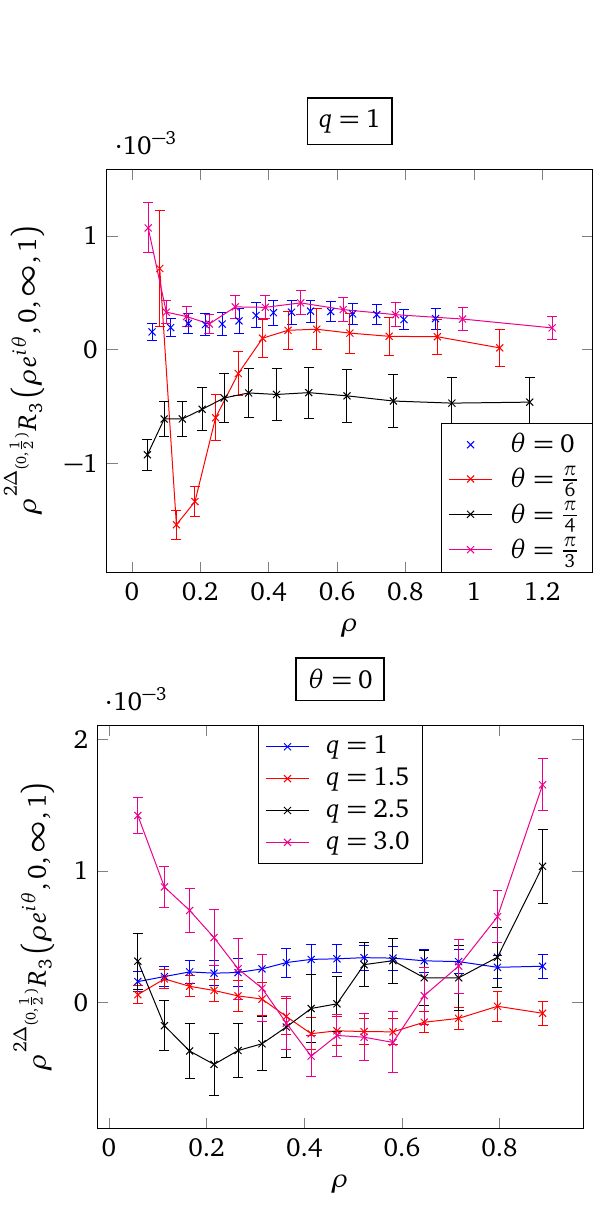
Figure 2: Differences between Monte-Carlo and numerical bootstrap calculations, with the error bars of the Monte-Carlo simulations. In all cases the difference is of the order of 10 − 3 or less, while the results themselves are of order